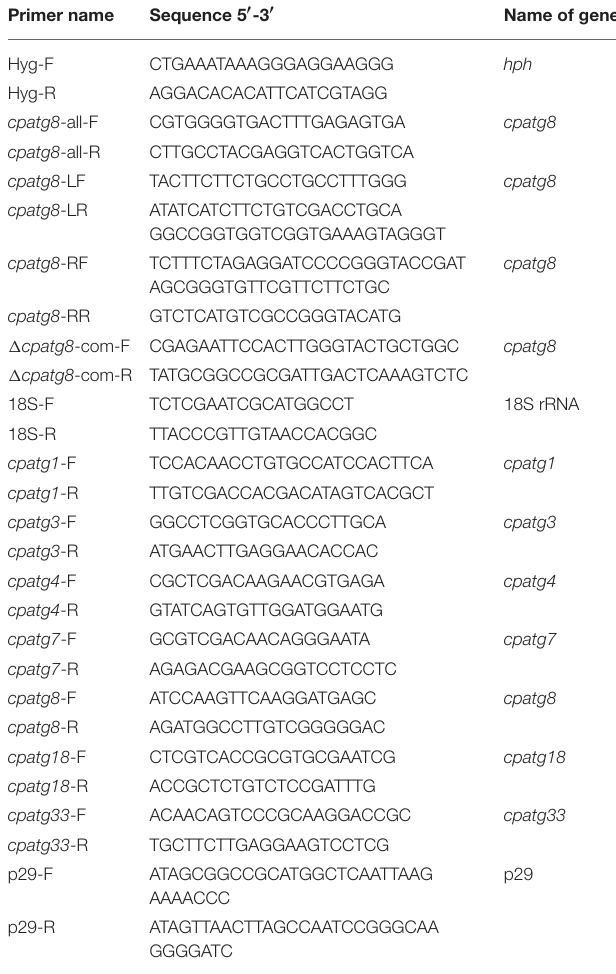
TABLE 1 | List of primers